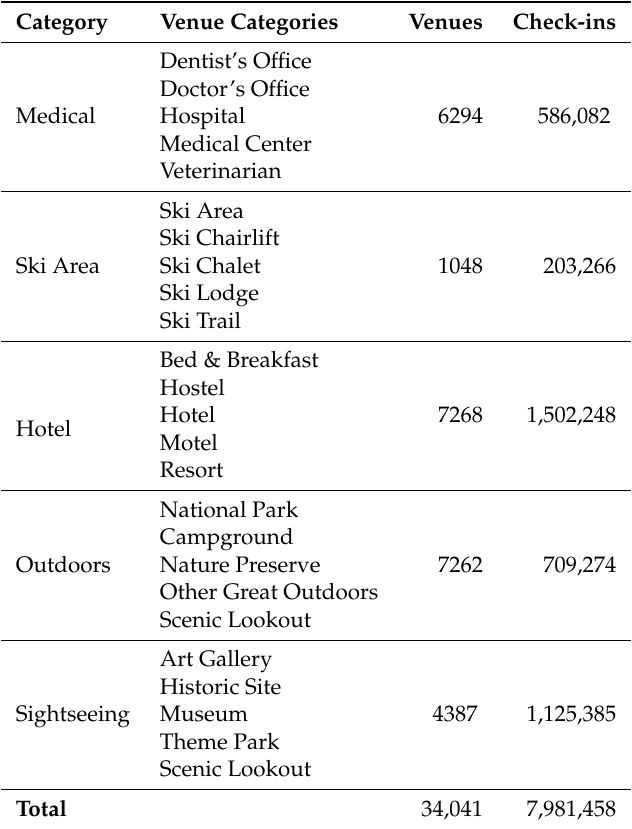
Table 2. Foursquare venue categories and